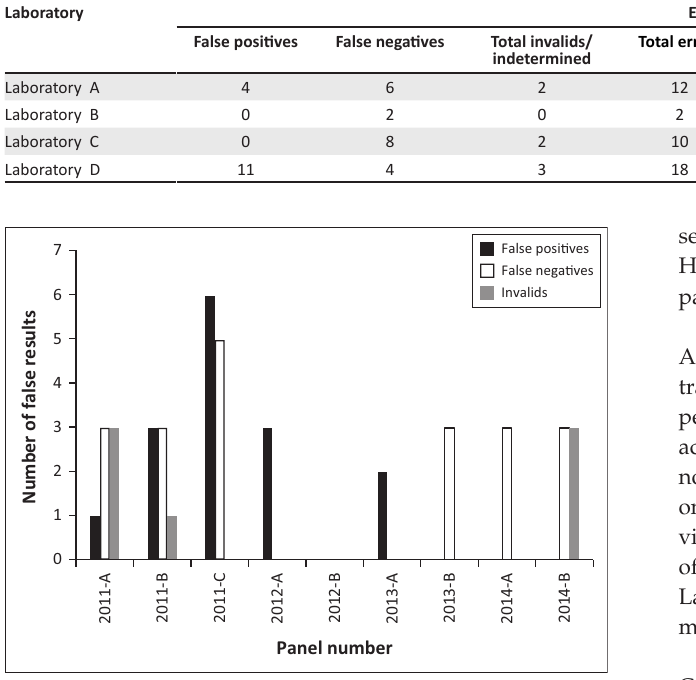
TABLE 2: Error characterisation of technicians per laboratory during the nine